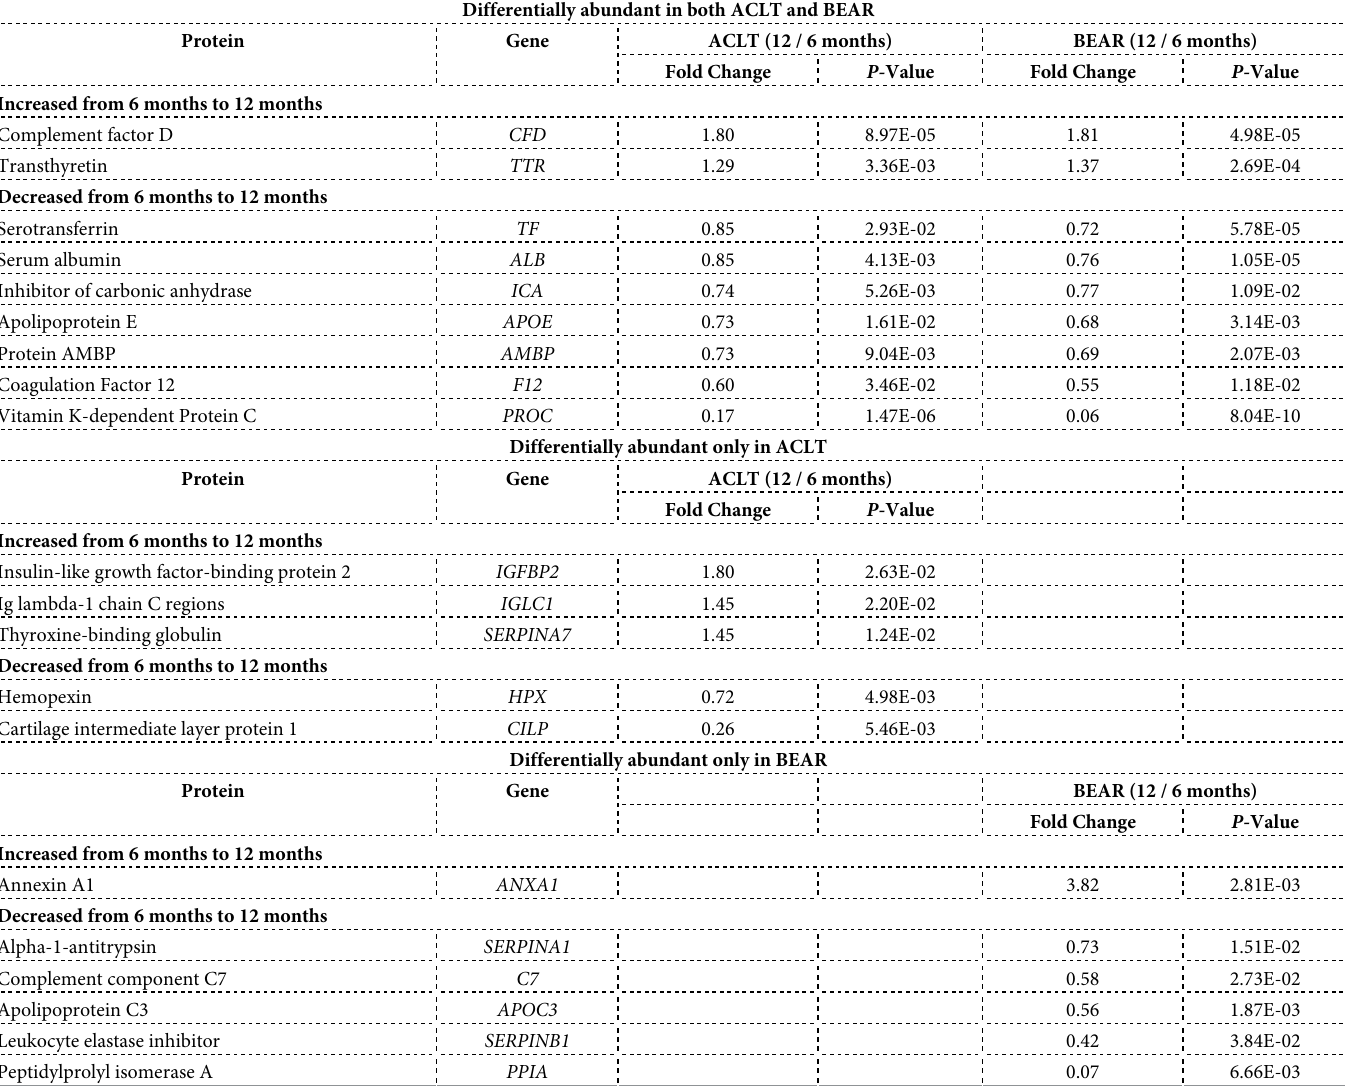
Table 4. Secreted proteins that are significantly different in abundance between 6 and 12 months after surgery. Differentially abundant in both ACLT and